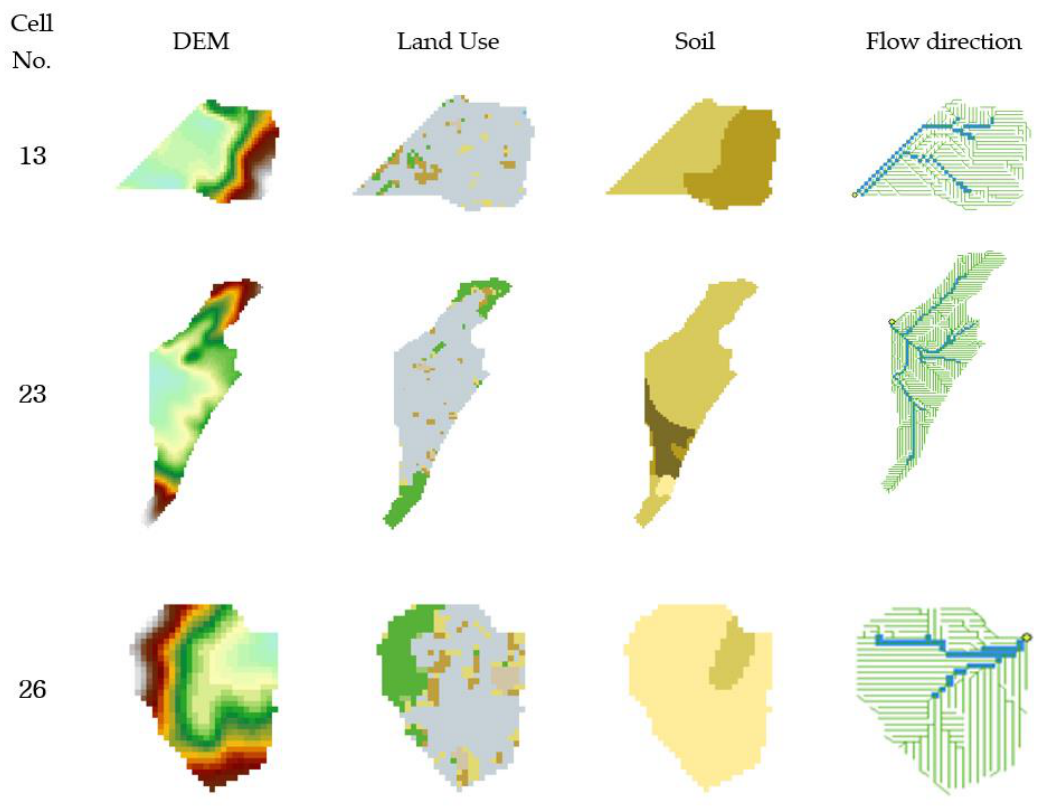
Figure 10. GIS (Geographic Information System) topographic data.